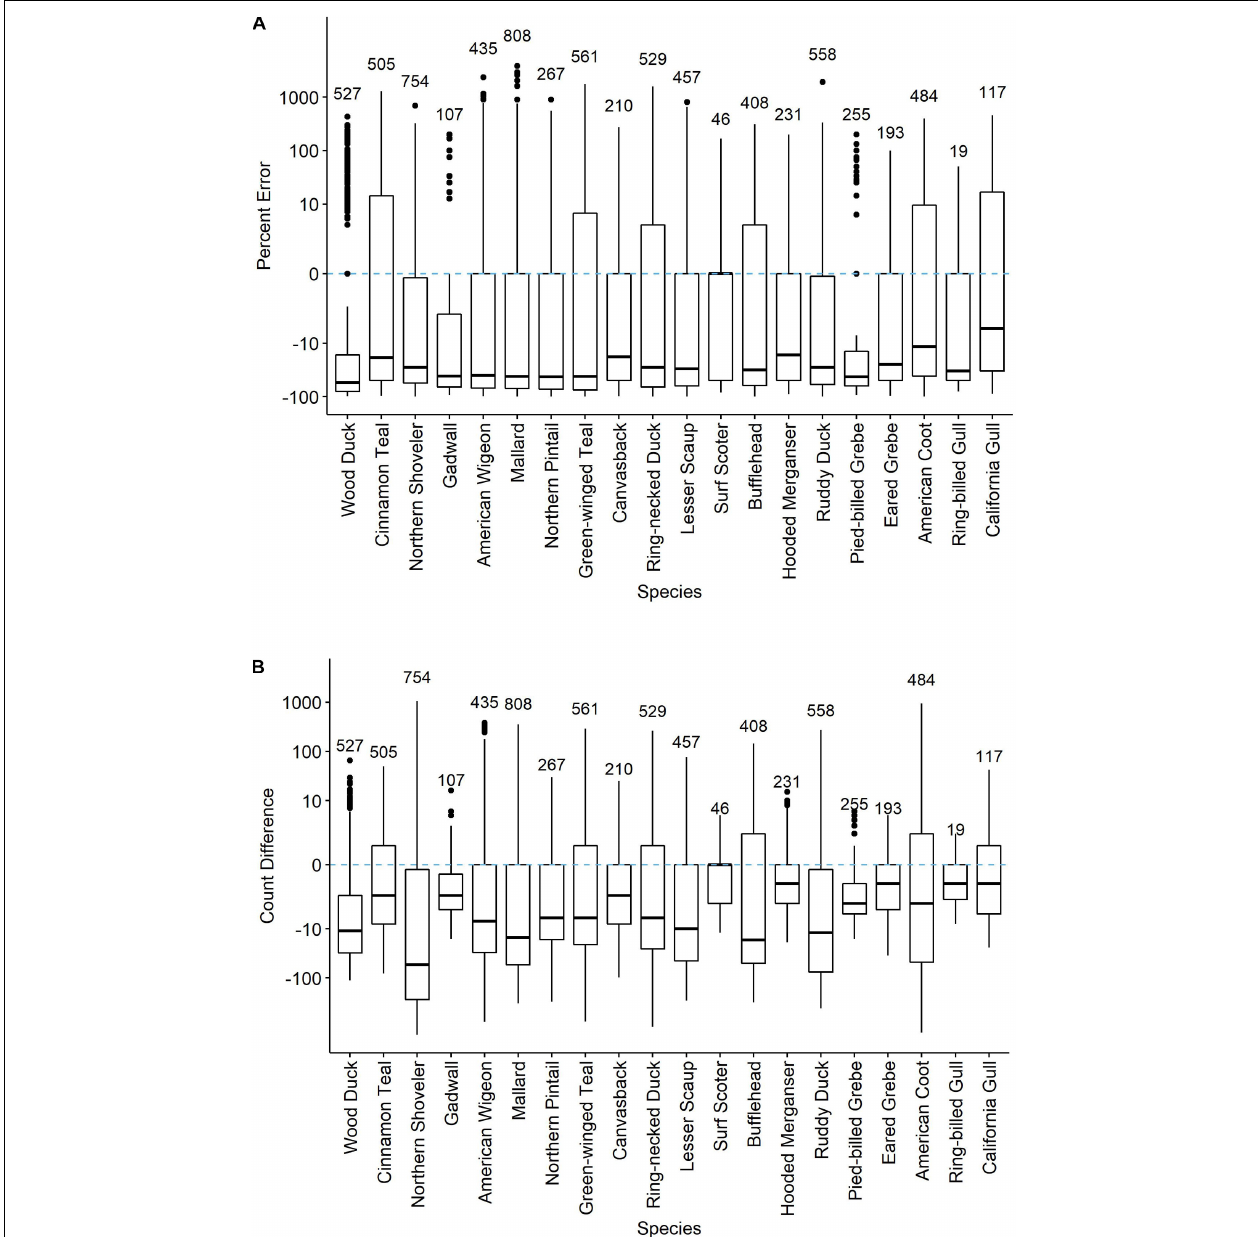
FIGURE 1 | Percent error (A) and count differences (B) in counts of 20 waterbird species reported on eBird checklists at the Philomath Ponds, Oregon USA, 2010–2019. Medians, quantile plots and outliers are indicated, as well as number of checklists reporting counts of each species. Only checklists reporting counts greater than zero were included. For checklists including counts of zero on dates when R* counts were non-zero, see Supplementary Figure 2